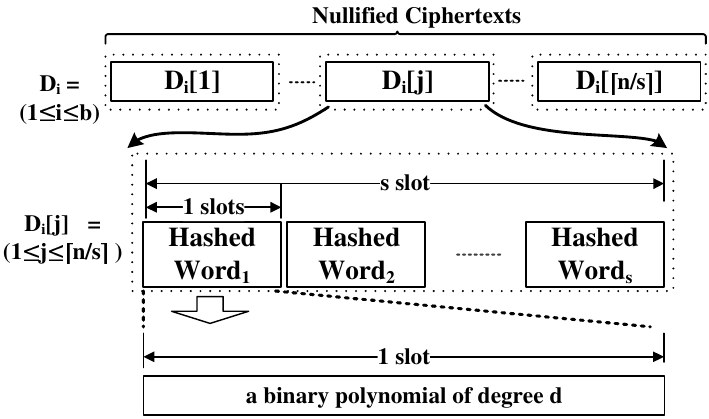
Figure 5. Dictionary